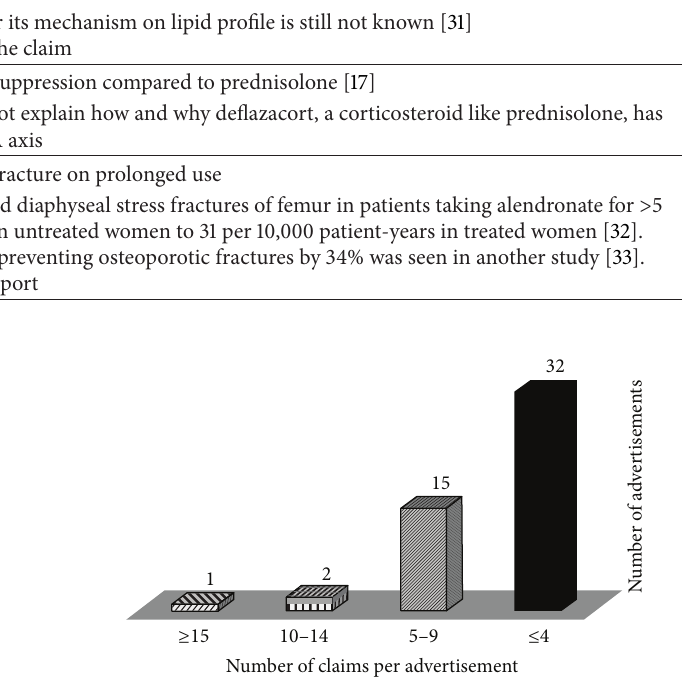
Figure 2: Graph depicting variation in number of claims per advertisement.